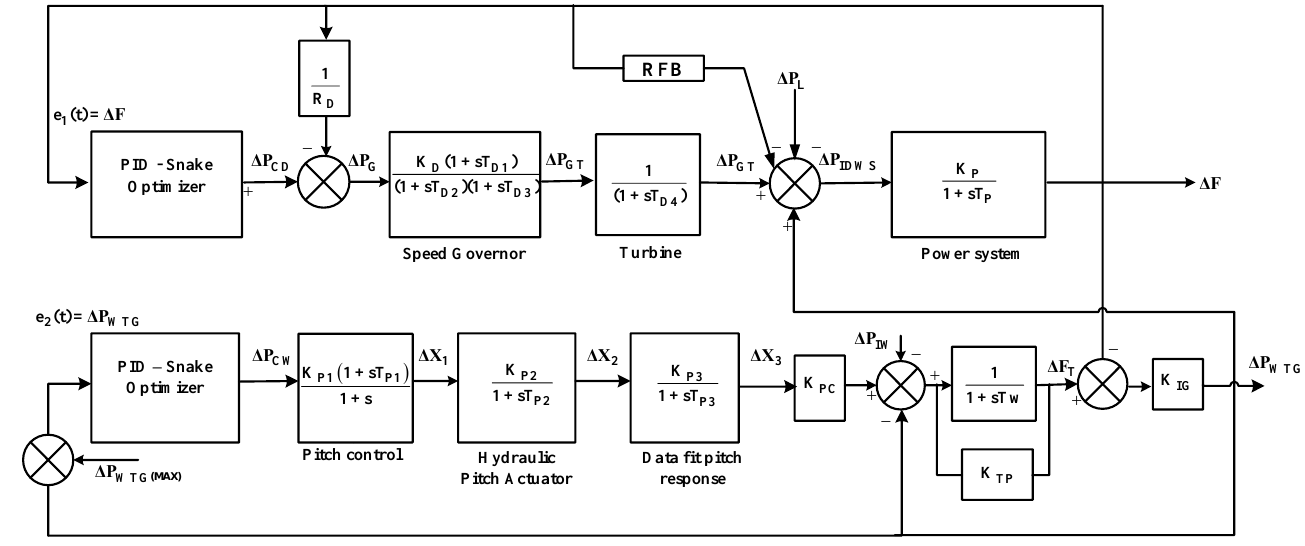
Figure 2. Diesel–wind isolated system with RFB.